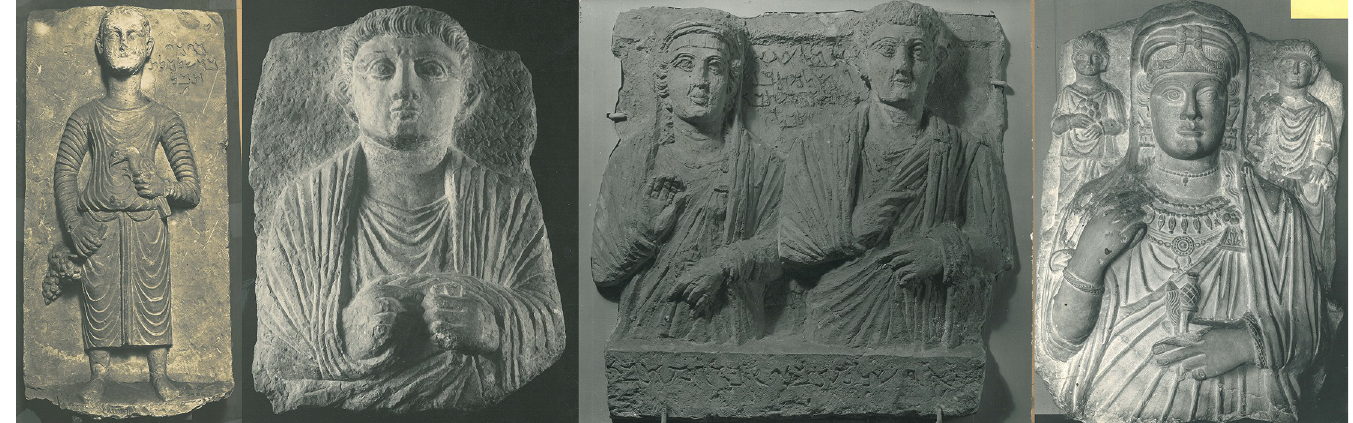
Fig 3. Loculus reliefs: Stele depicting a boy, Muse´e du Louvre, inv. no. AO 3984; relief depicting a male bust, National Museum of Damascus, inv. no. Dam 19; relief depicting two siblings, Antikensammlung der Friedrich-Alexander Universita¨t Erlangen, inv. no. 1184; relief depicting a mother and her two children, Arthur M. Sackler Museum, Harvard University, inv. no. 1908.3. All images © Palmyra Portrait Project, Ingholt Archive at Ny Carlsberg